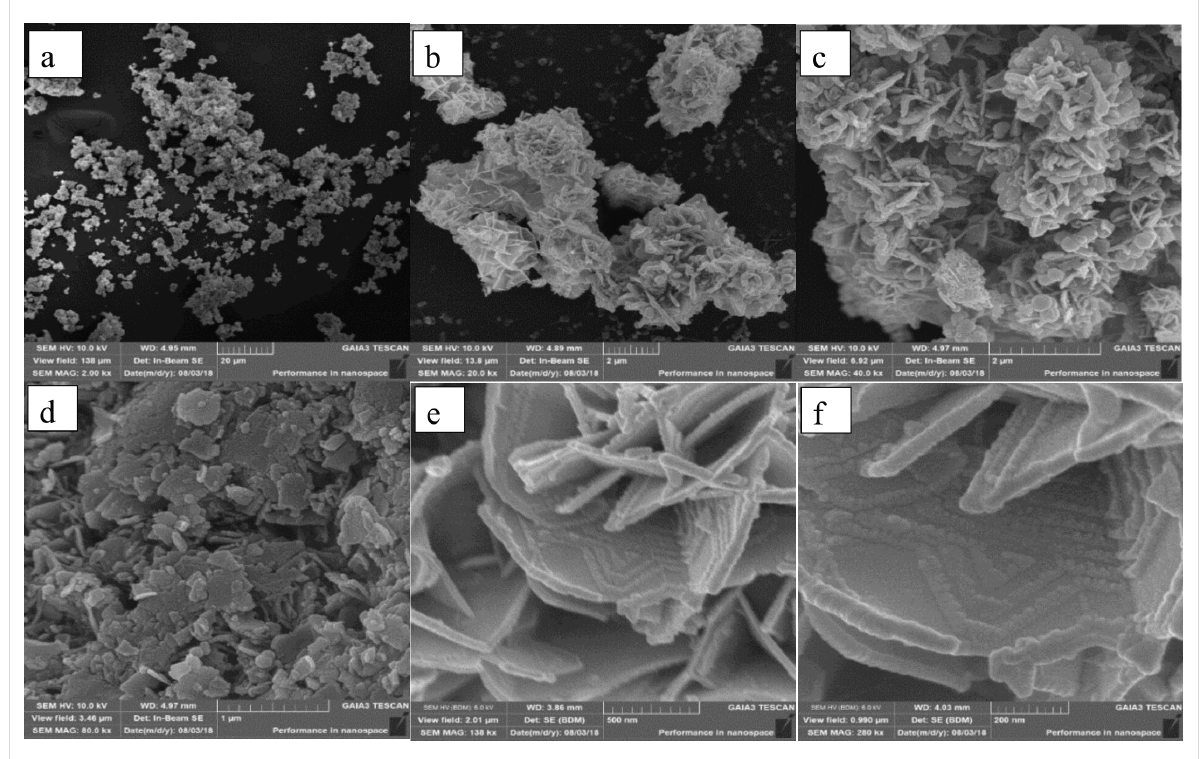
Figure 1: SEM micrographs (a) 2000× sample S3, (b) 20,000× sample S1, (c) 40,000× sample S3, (d) 80,000× sample S3, (e) 140,000× sample S1 and (f) 280,000× sample S1.